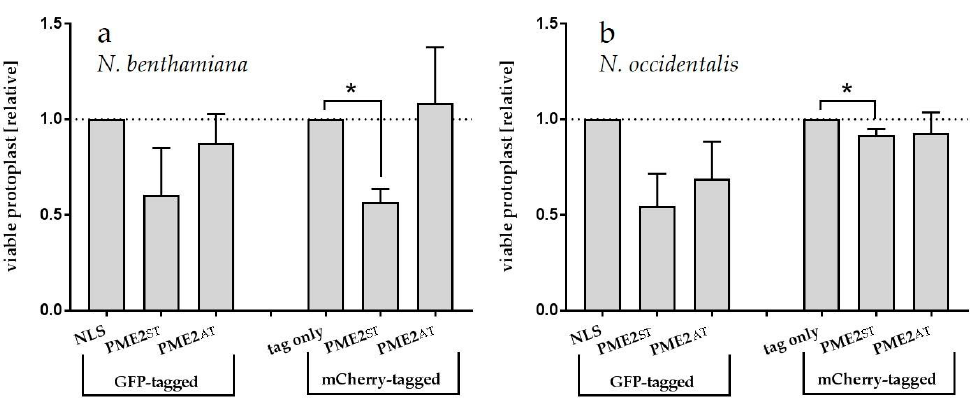
Figure 5. PME2 ST overexpression reduces viability of ( a ) N. benthamiana and ( b ) N. occidentalis